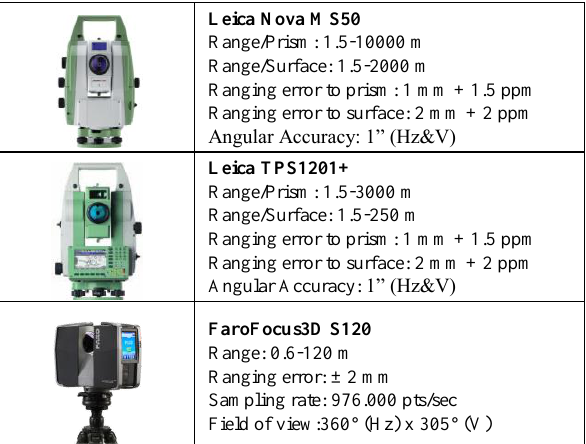
Figure 4. Surveying instruments with technical